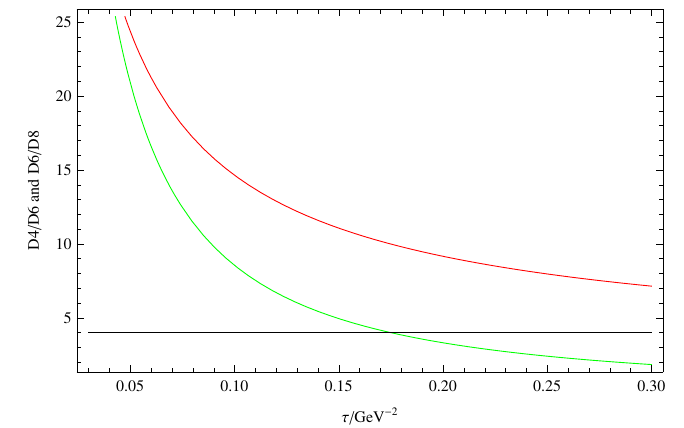
Figure 3 . Ratios of di(cid:11)erent dimension contributions to the OPE are shown as a function of (cid:28) for the u; d quark case. The red curve represents the 4D/6D ratio and the green line corresponds to 6D/8D.